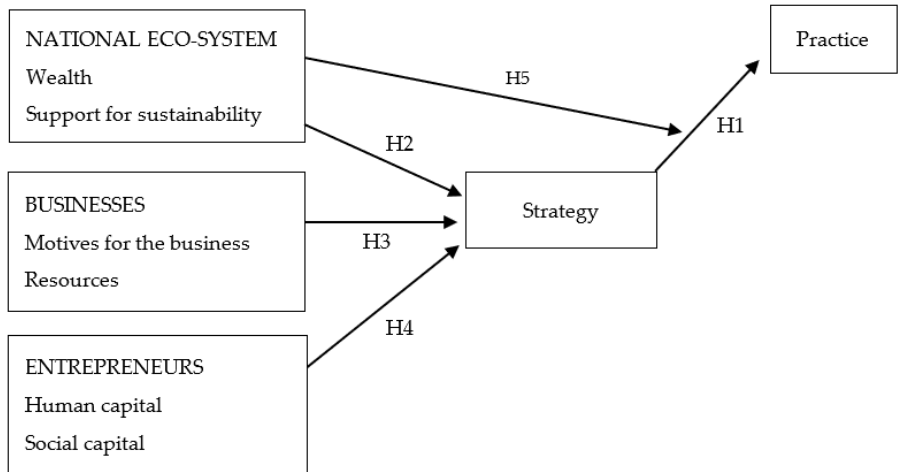
Figure 1. Model of strategy and practice of sustainability in businesses.